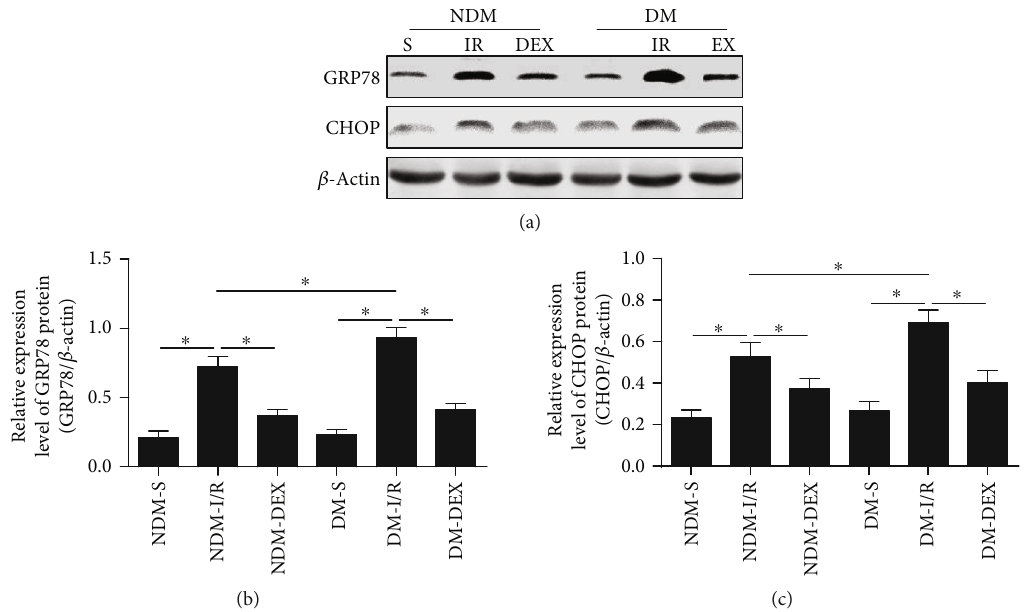
Figure 6: DEX reduces myocardial endoplasmic reticulum stress-related molecules GRP78 and CHOP in rats. GRP78 and CHOP protein expressions in myocardium were detected by western blot. (a) Western blot. (b) The bar graph of GRP78 protein expression. (c) The bar graph of CHOP protein expression. All results are expressed as the mean ± SD . ∗ P < 0 : 05 between each